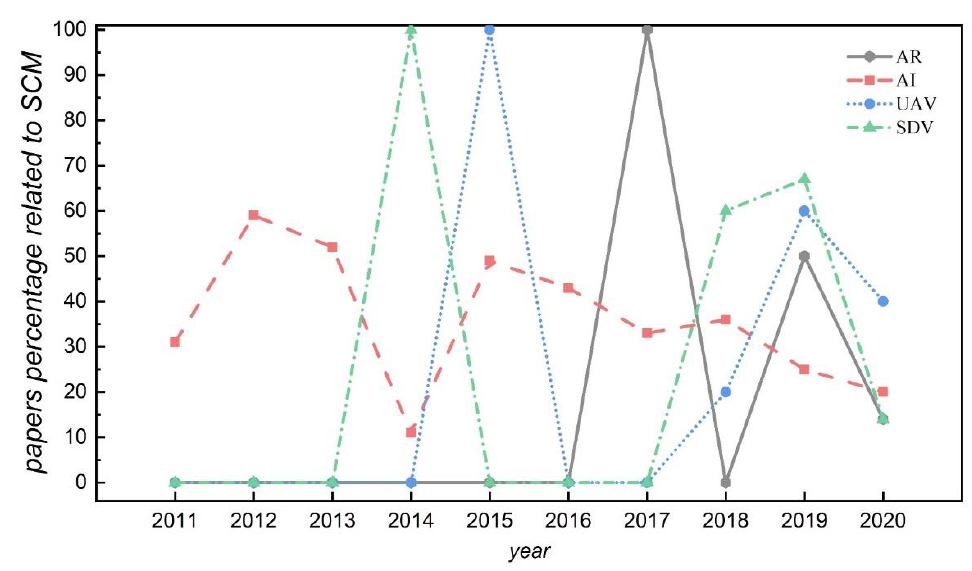
Figure 2. Most debated digital technologies in SC.